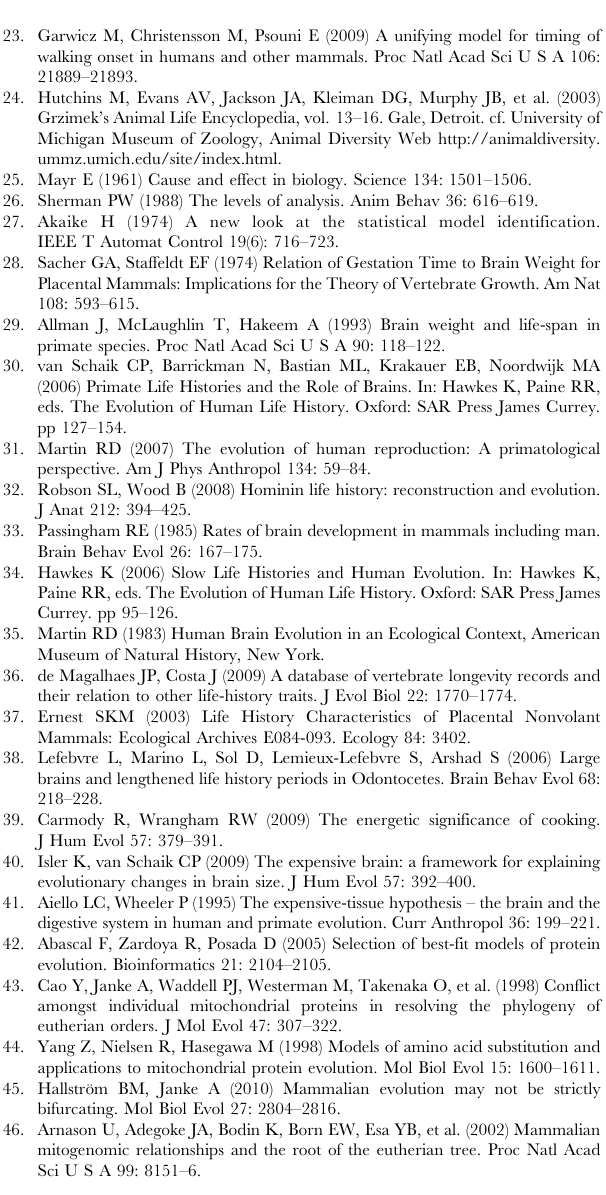
Table S2 Accession numbers and scientific names of species included in the analysis. Order as in the tree in Fig. 1.